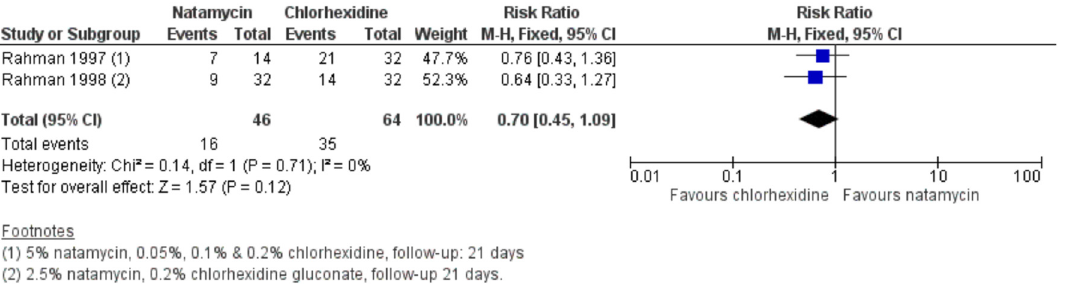
Figure 3. Forest plot of topical natamycin 5% versus chlorhexidine 0.2% (outcome: clinical cure). Reproduced from FlorCruz NV, Evans JR. Medical interventions for fungal keratitis. The Cochrane Database of Systematic Reviews 2015; 4 : CD004241 with permission from John Wiley and Sons [ 5] .